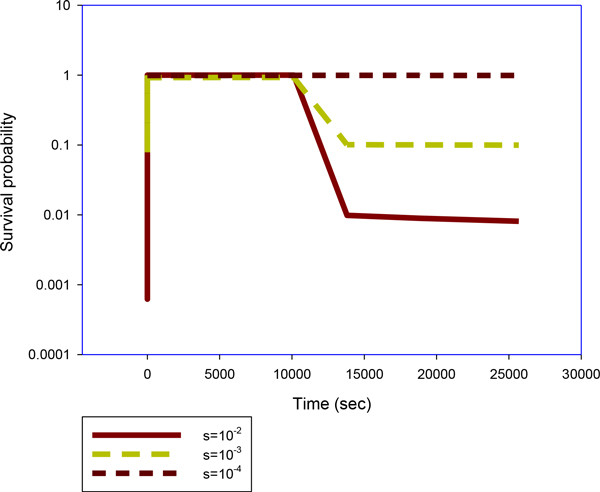
Survival probability curves. A sample of a survival probability curves as predicted by the Blahut Arimoto algorithm for the cell model. Value of the parameter s = -10-2, -10-3, -10-4 Photon density ρ = 106 cm-3. Photo sensitizer (Photofrin) concentration in a cell [S0] = 5 × 1013 cm-3. Single cell oxygen concentration [3O2] = 6.06 × 1017 cm-3.